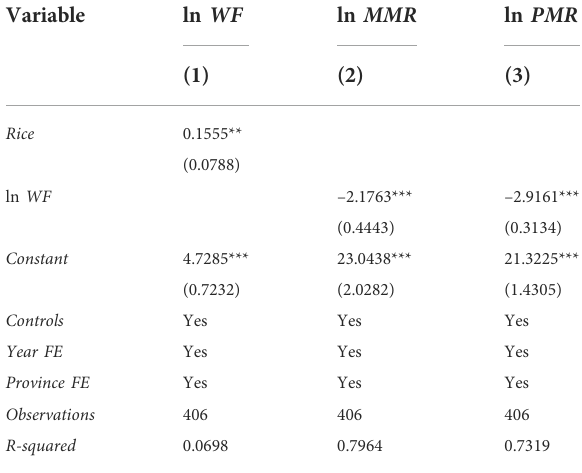
TABLE 5 Two-stage instrumental variable